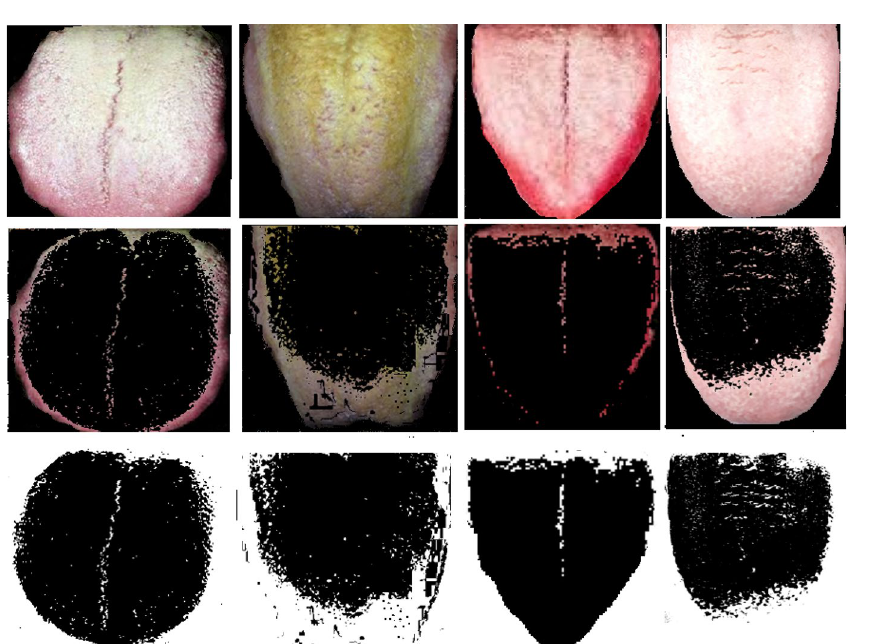
Figure 7. Fur layer extraction of the considered tongue